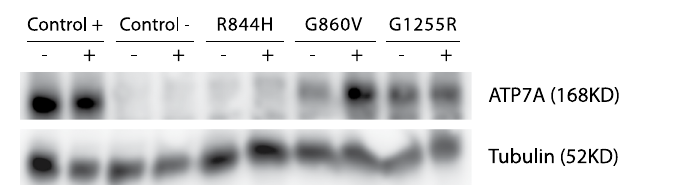
Figure 7. WB of lysates from MD fibroblasts cultured in the absence or presence of 25 µ M Bortezomib, respectively. The MD fibroblasts contain different missense mutations as indicated. Control + is lysate from normal fibroblasts. Control − is lysate from MD fibroblast, containing a big deletion of the ATP7A gene